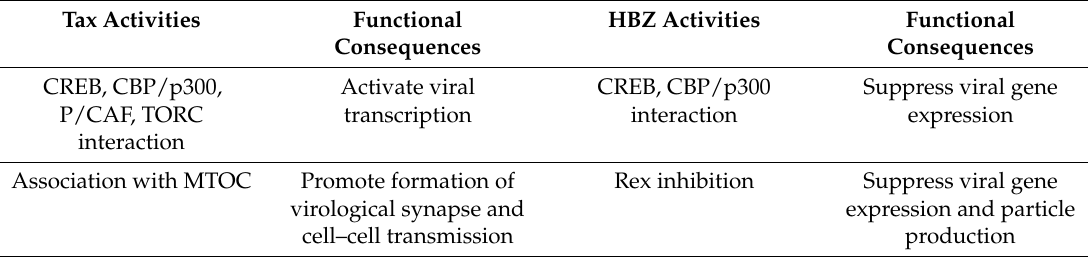
Table 1. A comparison of the activities and functional consequences of Tax and HTLV-1 basic zipper protein